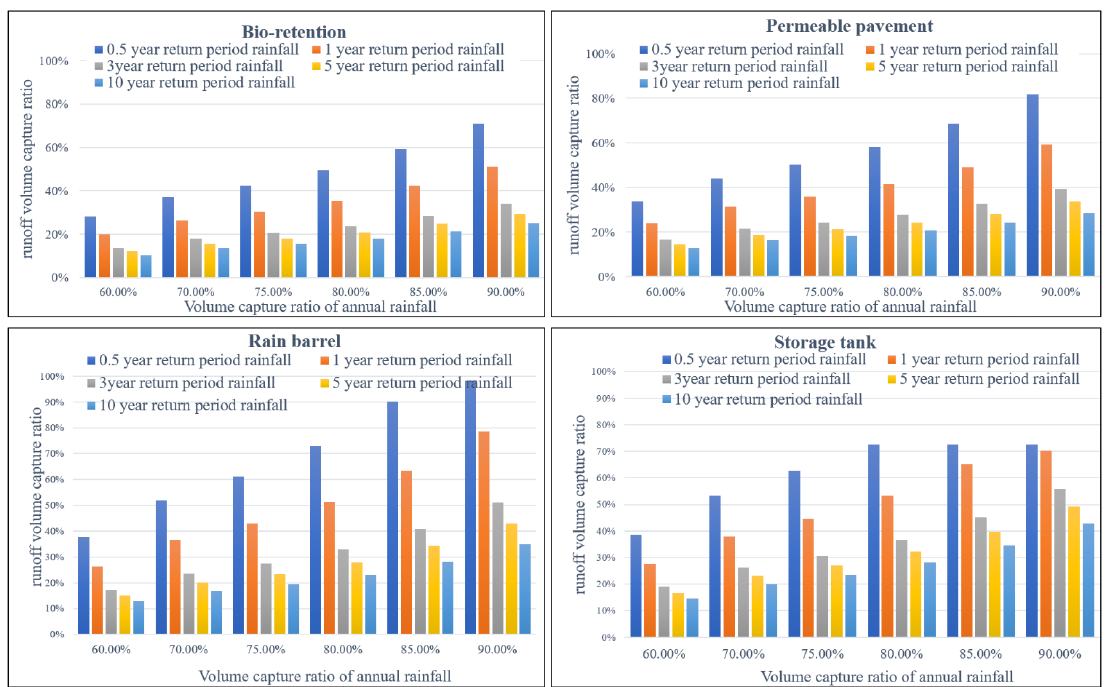
Figure 5. Correspondence between the total annual runoff control rate and the runoff volume control rate.